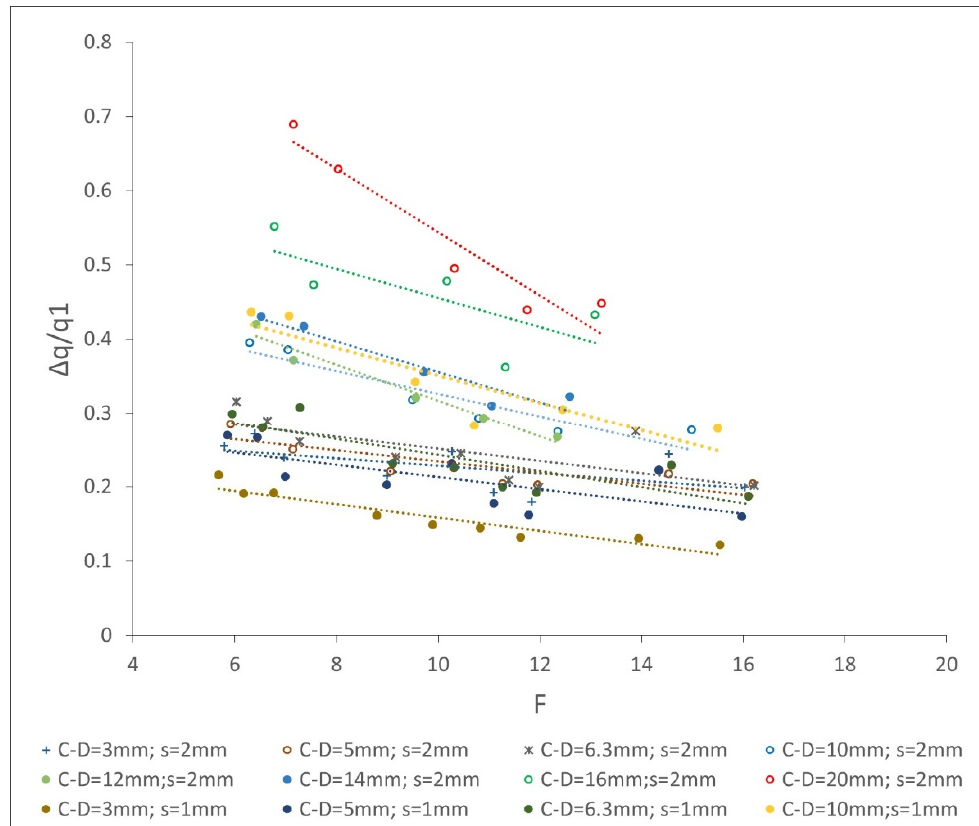
Figure 16. Relations for circular wire screen between Δ q / q 1 and Froude number .